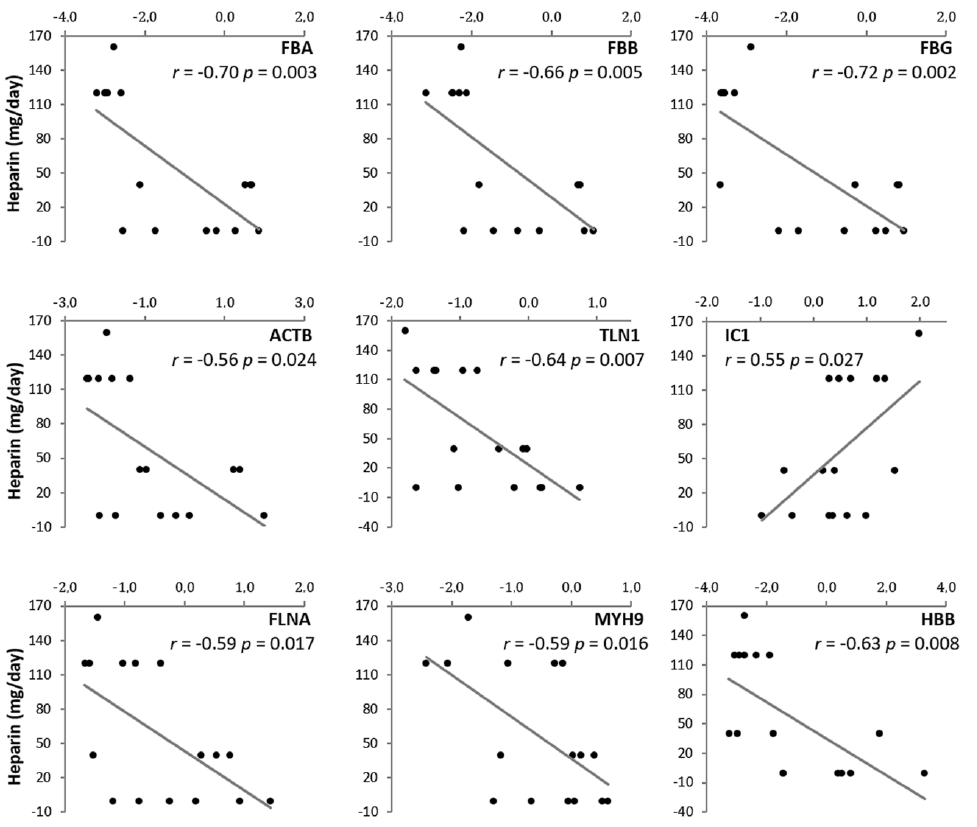
Figure 4. Correlations between coagulation proteins and heparin dose. Y-axis represents heparin dose while x-axis represents Zq values of the different proteins. Two-tailed Pearson’s correlation coefficient was calculated to analyze the association between two variables. Pearson coefficient and p -value are shown.